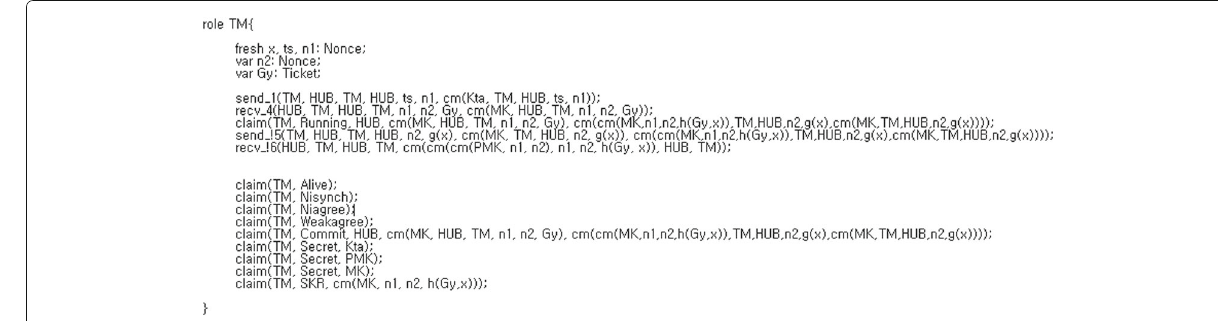
Fig. 5 Policy update